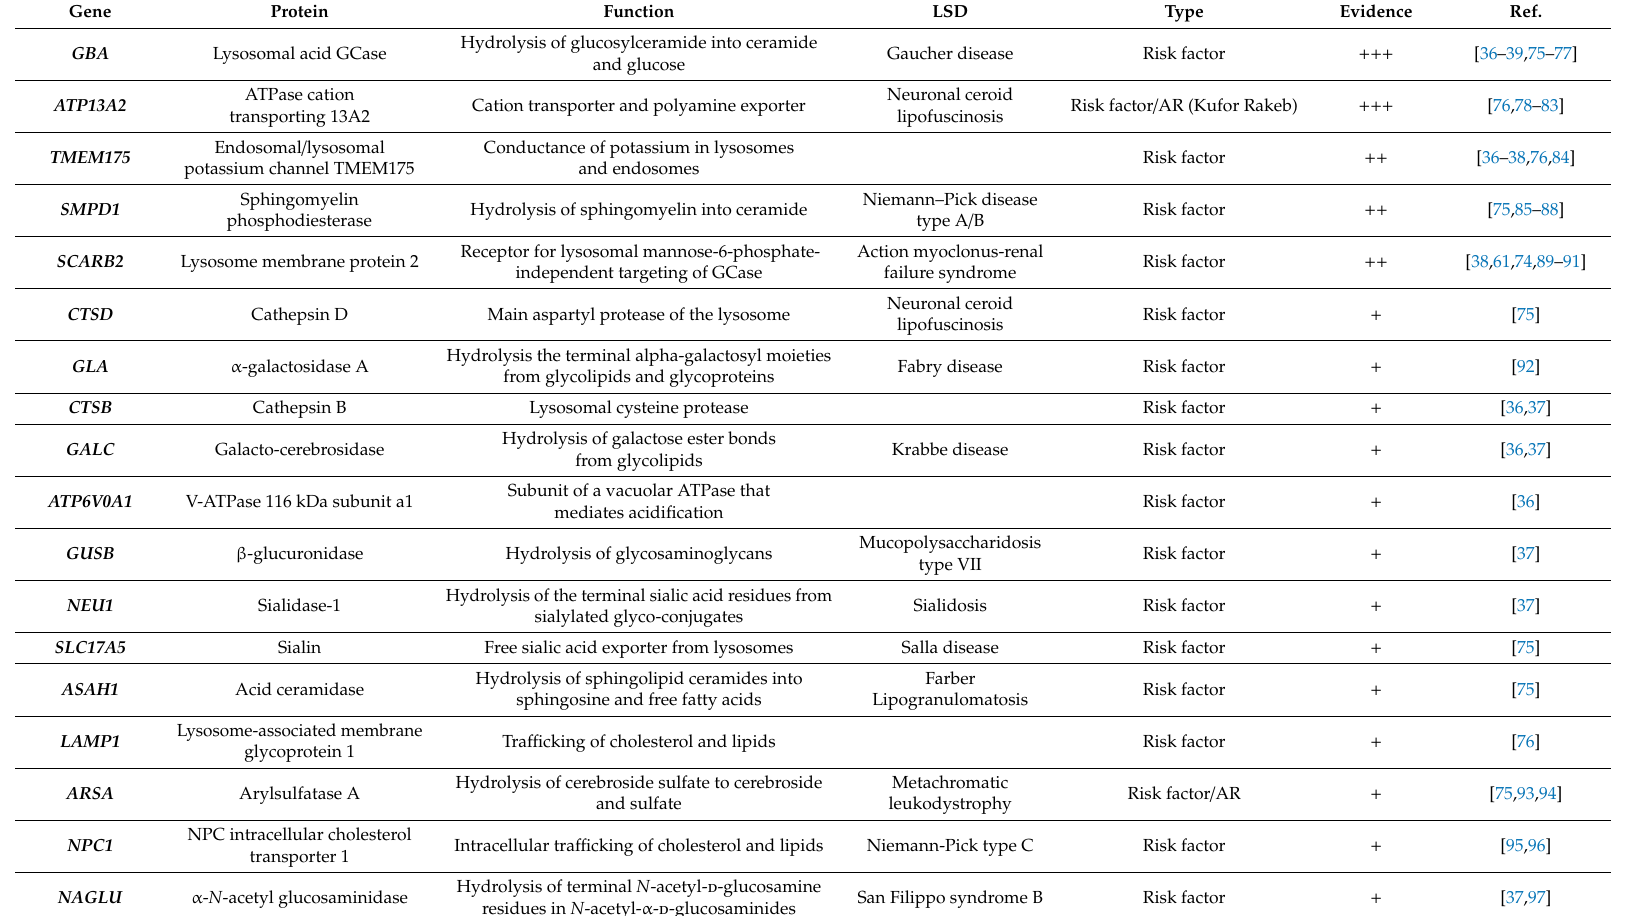
Table 1. Lysosomal genes associated with